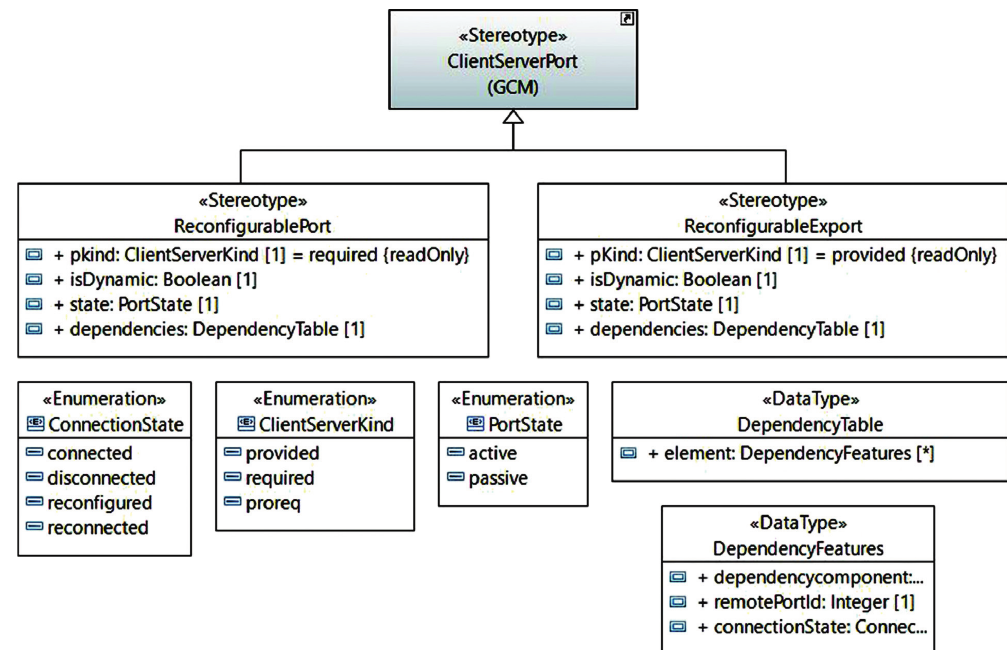
Figure 7: Extended GCM